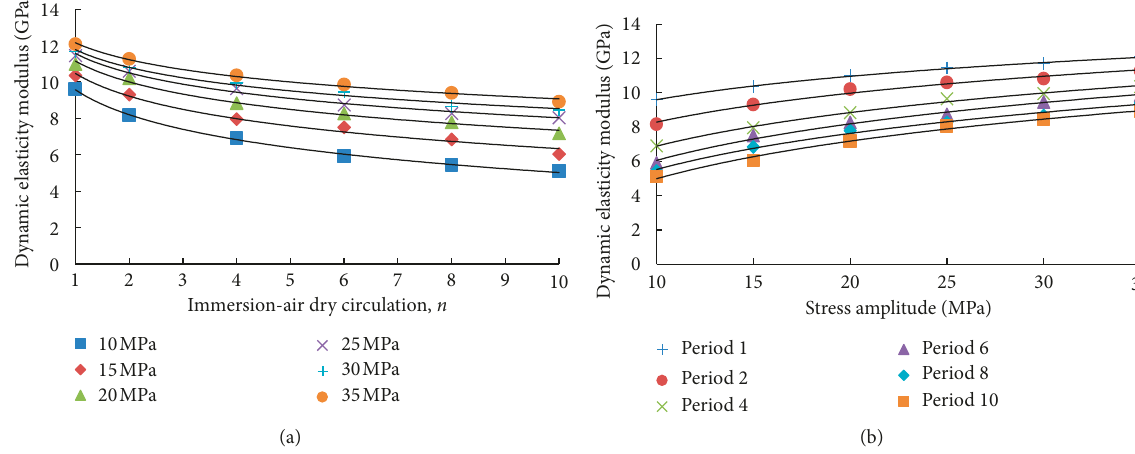
Figure 11: Dynamic elasticity modulus variation curves of the rock sample under water-rock interaction. (a) The relation curve of dynamic modulus of elasticity with water-rock cycle. (b) The relation curve of dynamic modulus of elasticity with cyclic load stress